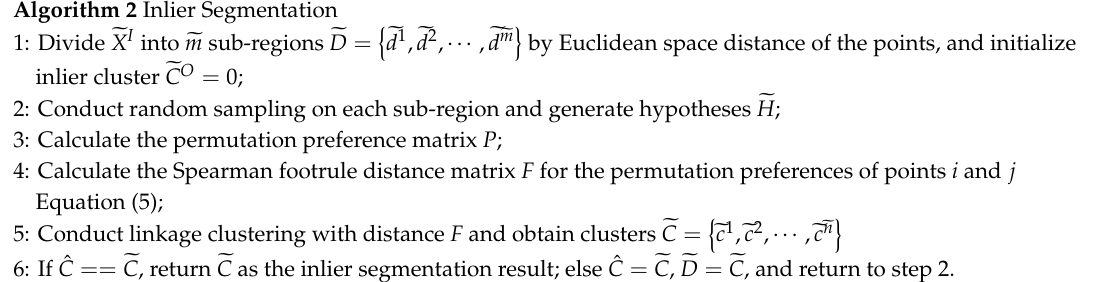
Algorithm 2 Inlier